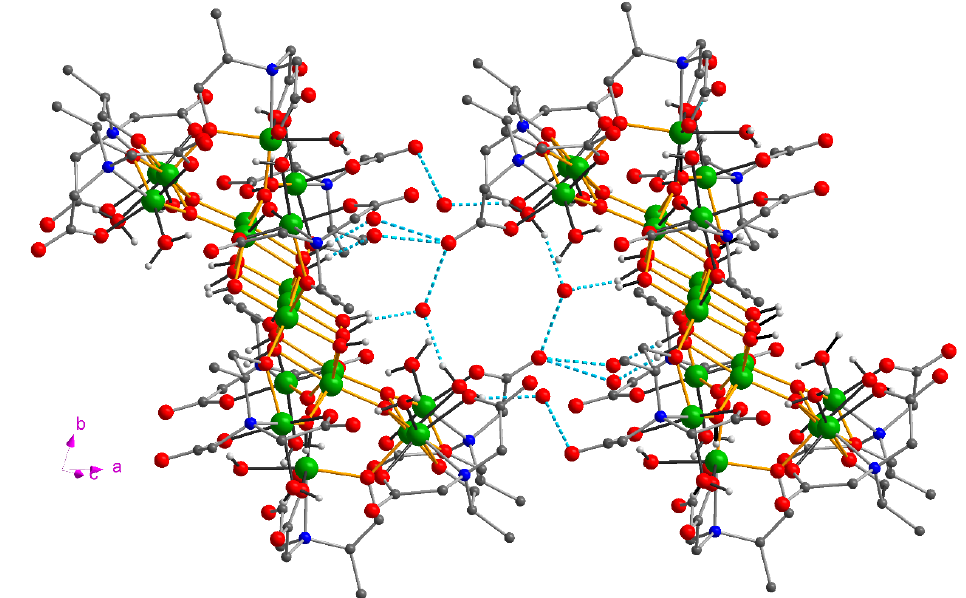
Figure A1. Intercluster hydrogen-bonding (shown as light blue dashed lines) between the Fe 19 cluster and its symmetry-equivalent at {x + 1, y, z}. Note that H-atoms on the lattice waters were not located in the structural determination.